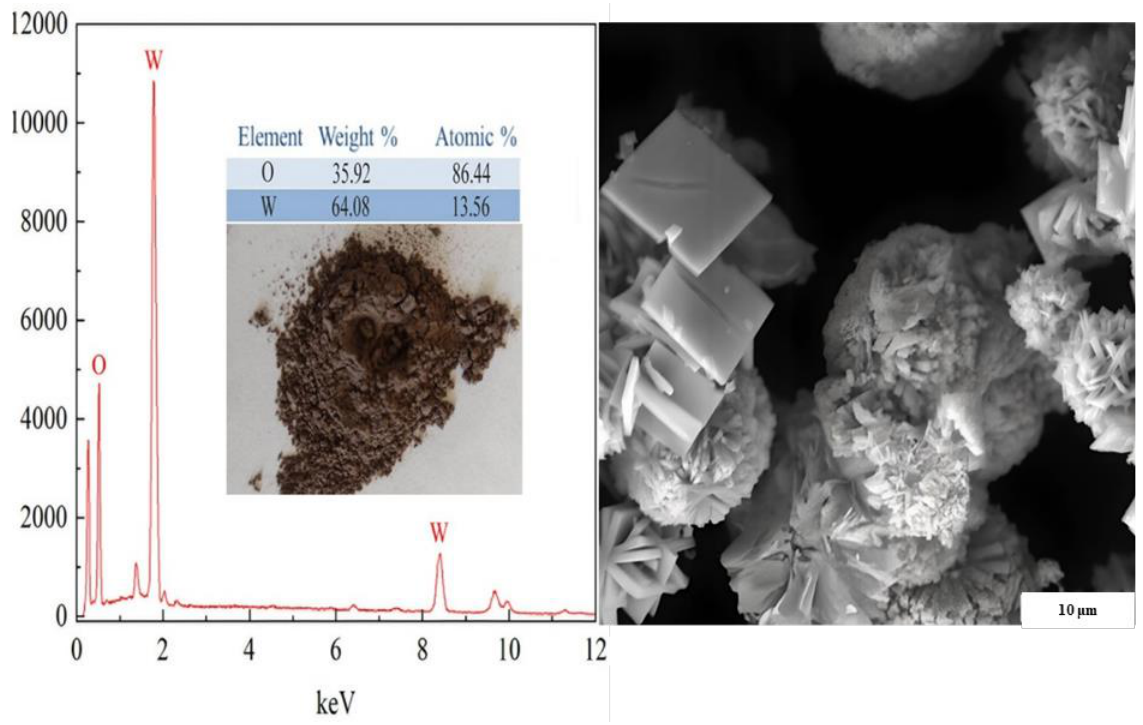
Figure 20. SEM-EDX analysis of obtained tungsten oxide product.